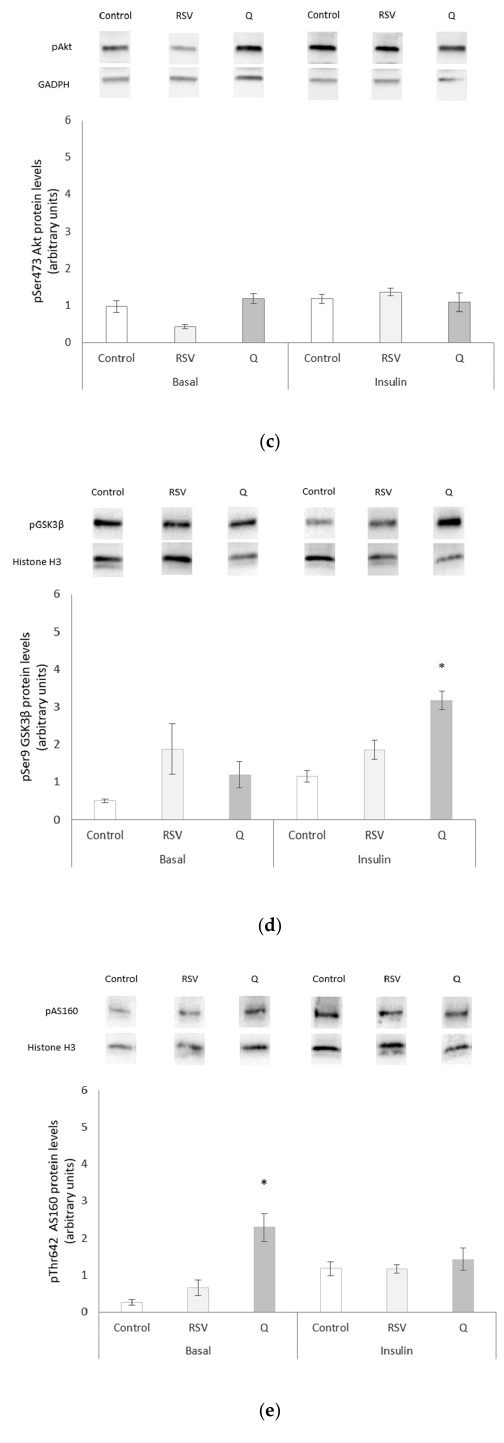
Figure 3. Protein expression of AMPK ( a ), IRS-1 ( b ), Akt ( c ), GSK3 β ( d ), and AS160 ( e ) in human myotubes that were treated with 0.1 µ M of resveratrol (RSV) and 10 µ M of quercetin (Q) for 24 h in the presence or absence of insulin, with the exception of AMPK, which was measured only in basal conditions. Target protein bands are shown on the chart top as representative blot images. All of the data are presented as the mean ± SEM of six biological replicates. Comparisons between each treatment group and the control group were analysed by Student’s t -test. The asterisks represent differences versus the controls (* p < 0.05; ** p <